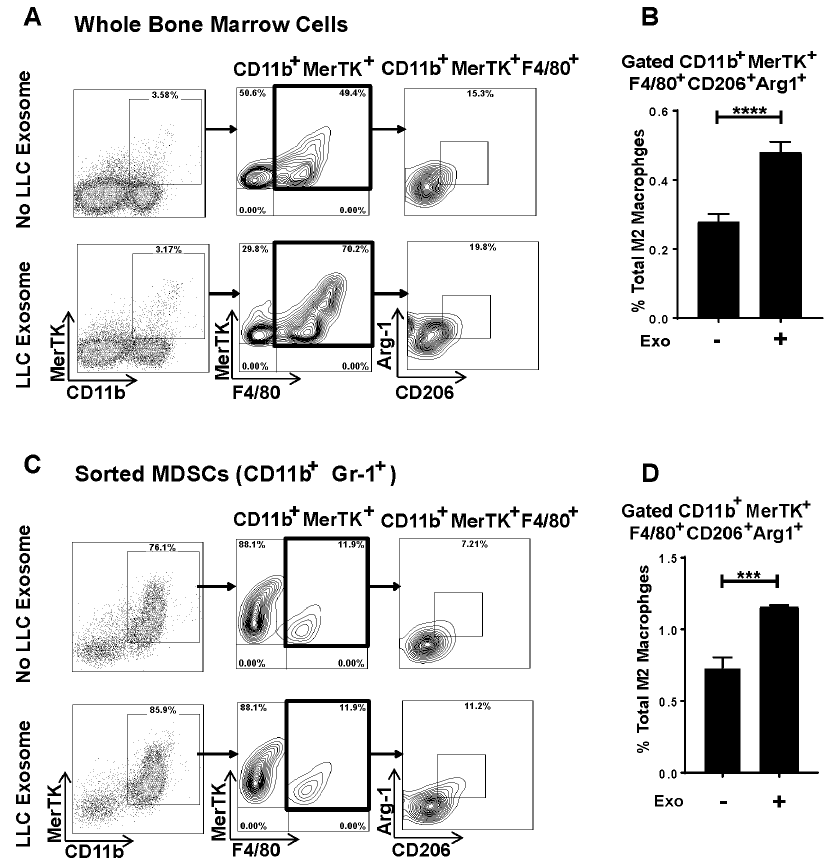
Figure 5. Syngeneic lung cancer cell lewis lung carcinoma (LLC)-derived exosomes induce M2 polarization and also di ff erentiate MDSCs to M2 phenotype. Bone marrow (BM) cells from wild type (WT) mice were seeded then co-cultured with LLC derived exosomes in 10:1 ratio (10 exosomes / cell)